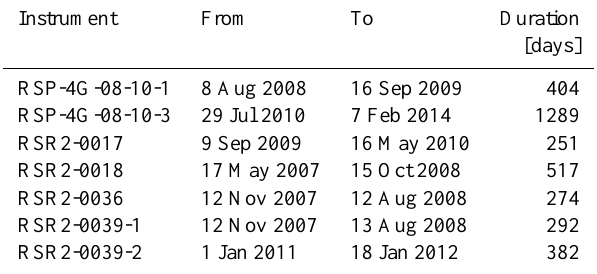
Table 5. Evaluated data sets.